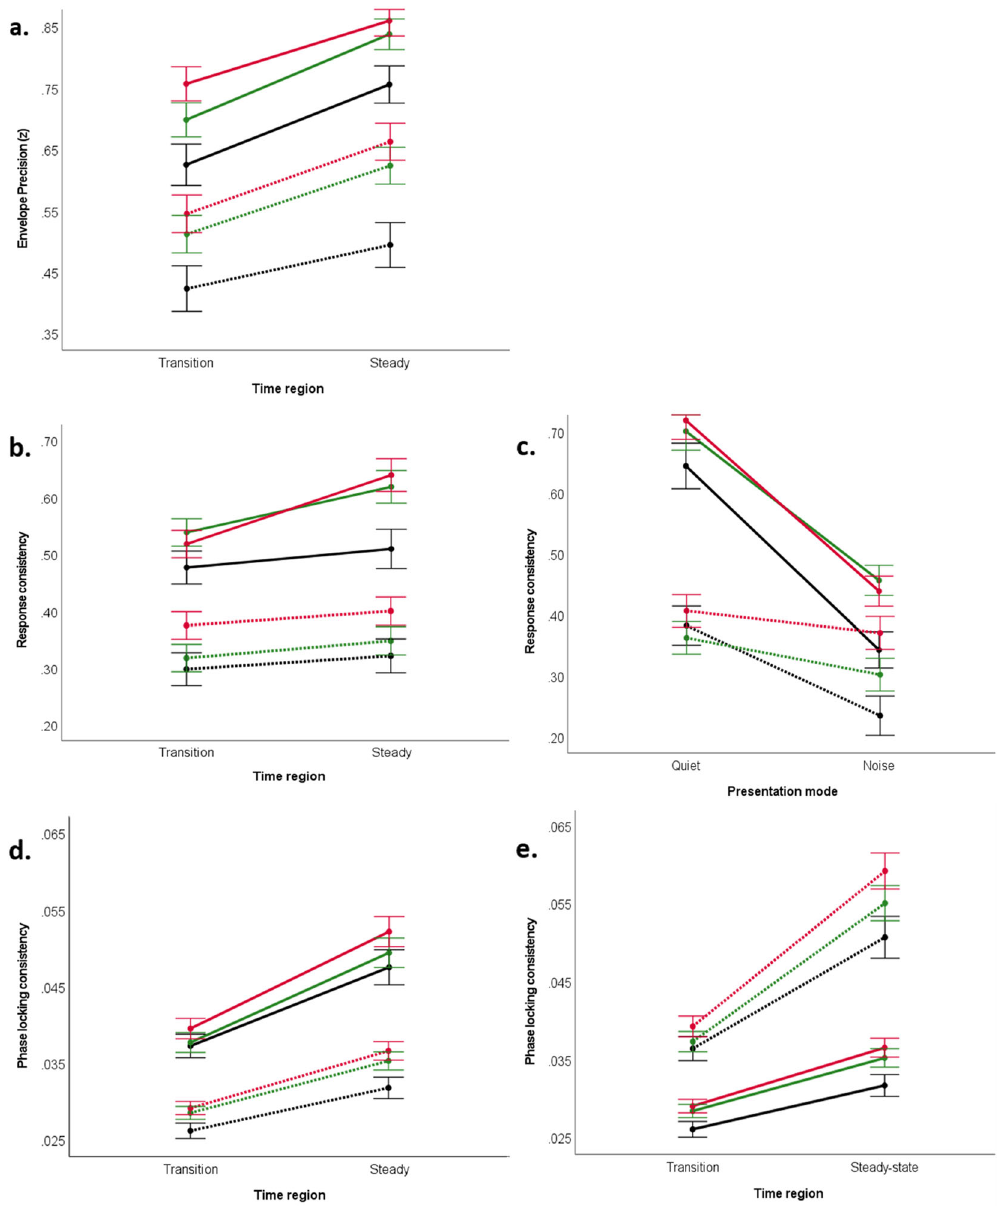
Fig. 7 Interaction between presentation mode, time region of the FFR, frequency, and synchronization ability group (Non-synchronizer: dark gray, Synchronizer: red, Synchronizer at one rate only: green) in determining envelope-encoding precision, response consistency, phase-locking consistency. ( a ) Envelope-encoding precision, Quiet: solid line - Noise: dotted line; ( b , c ) response consistency, Added: solid line-Subtracted: dotted line; ( d ) phase-locking consistency, Quiet: solid line-Noise: dotted line; ( e ) phase-locking consistency, Low frequency: solid line; High frequency: dotted